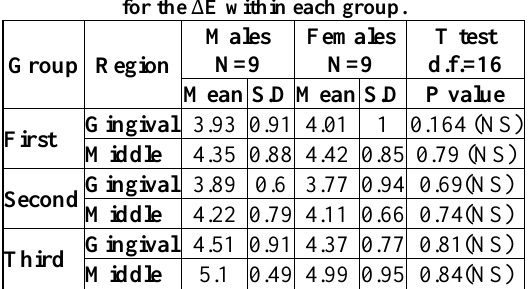
Table 3: ANOVA test to detect the difference in ∆ E between the three groups included in this study for the gingival thirds.